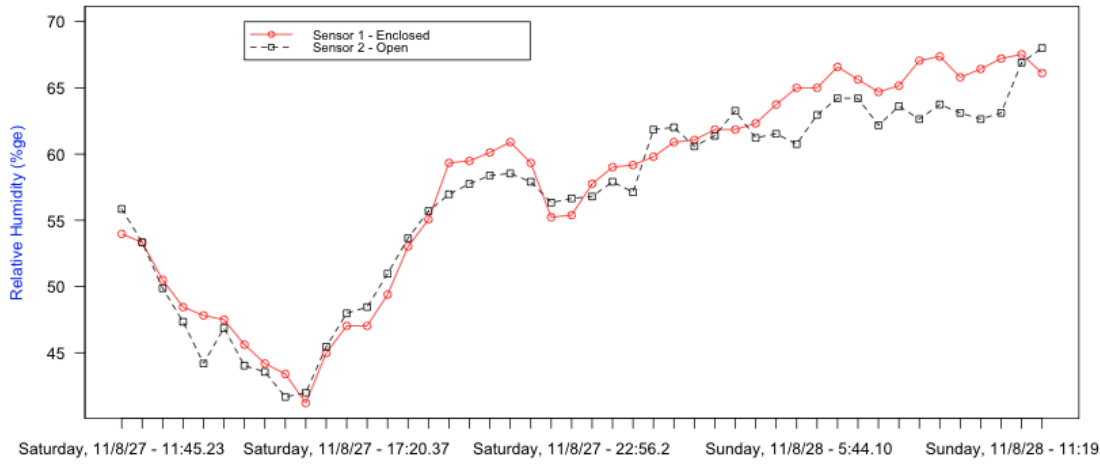
Figure 12. Behavior of relative humidity sensors in and outside of Perspex